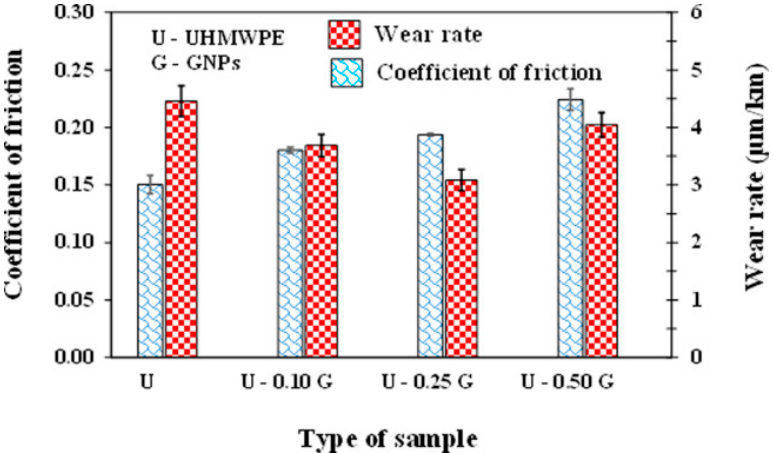
Figure 8. The COF of UHMWPE for different aging times. Reprinted with permission from [134].